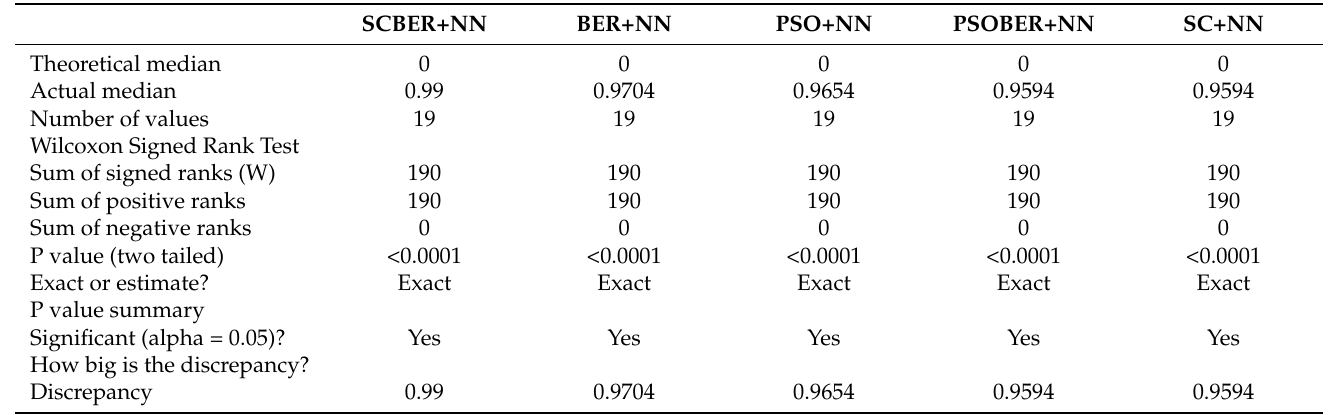
Table 12. The Wilcoxon signed-rank test for evaluating the performance of the proposed optimization algorithm, SCBER, compared to other competing optimization methods.